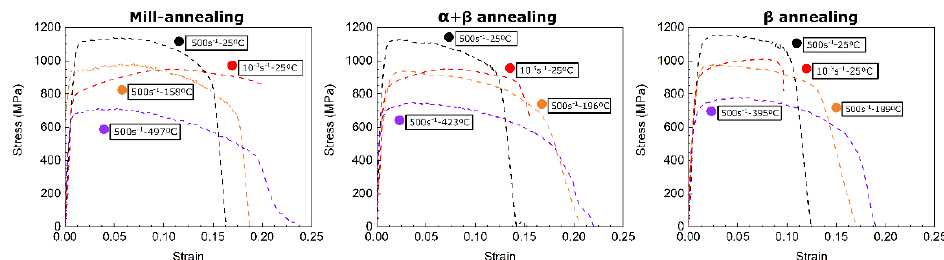
Figure 5: Experimentally observed behaviour of Ti-6Al-4V as a function of the temperature, strain rate and